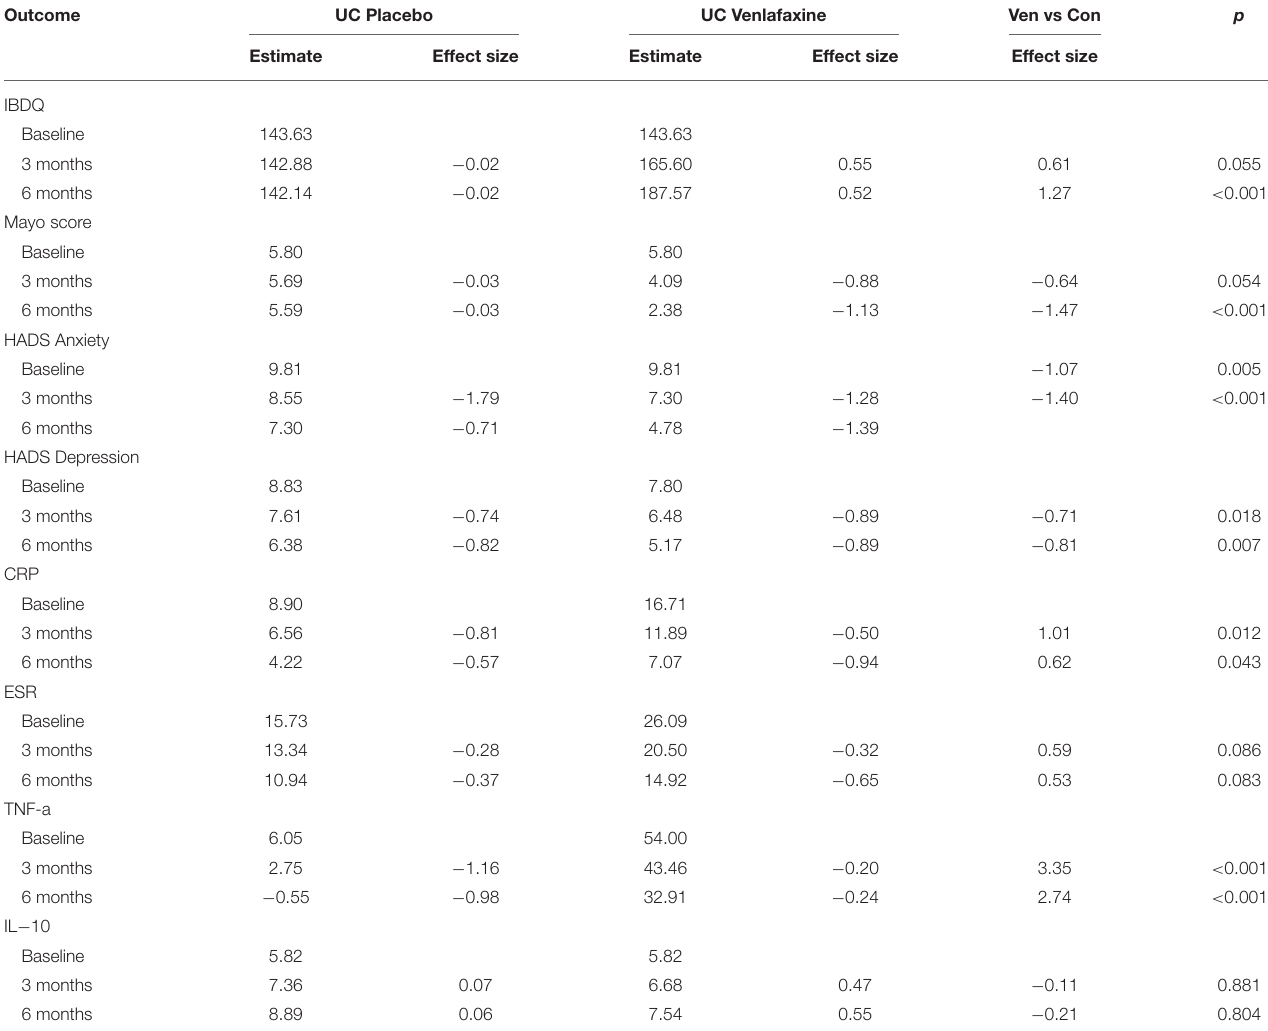
TABLE 3 | Estimates and effects sizes for venlafaxine group and placebo group in UC. Outcome UC Placebo UC Venlafaxine Ven vs Con p Estimate Effect size Estimate Effect size Effect